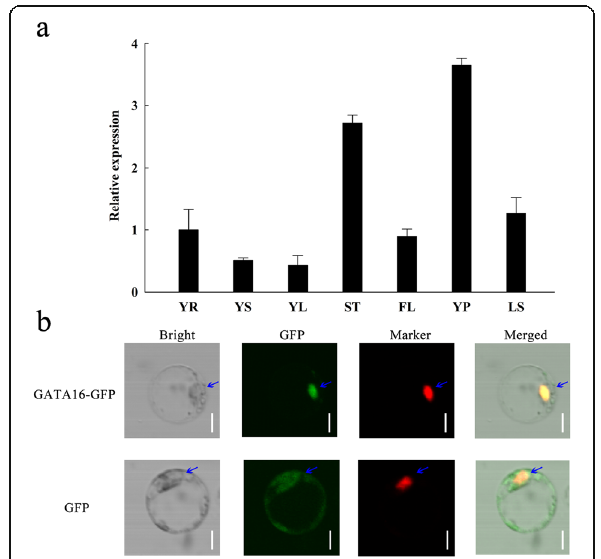
Fig. 3 Tissue-specific expression and subcellular localization of OsGATA16 in rice. a OsGATA16 expression in different plant tissues. Root (YR), stem (YS), and leaves (YL) at the seedling stage, and stem (ST), flag leaves (FL), panicles (YP), and leaf sheaths (LS). Data represent the mean ± SE from three replicates. b Subcellular localization of OsGATA16 in rice. GATA16-GFP: GFP fusion with OsGATA16 protein; D53-RFP: nuclear marker. Arrows indicate nuclei. Bar = 10 μ m